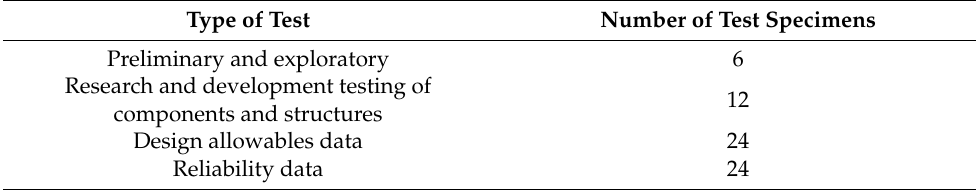
Figure 3. Schematic for the CFRP fiber orientation. Table 1. Number of specimens required for each stress–number of cycles (S–N) curve [22].